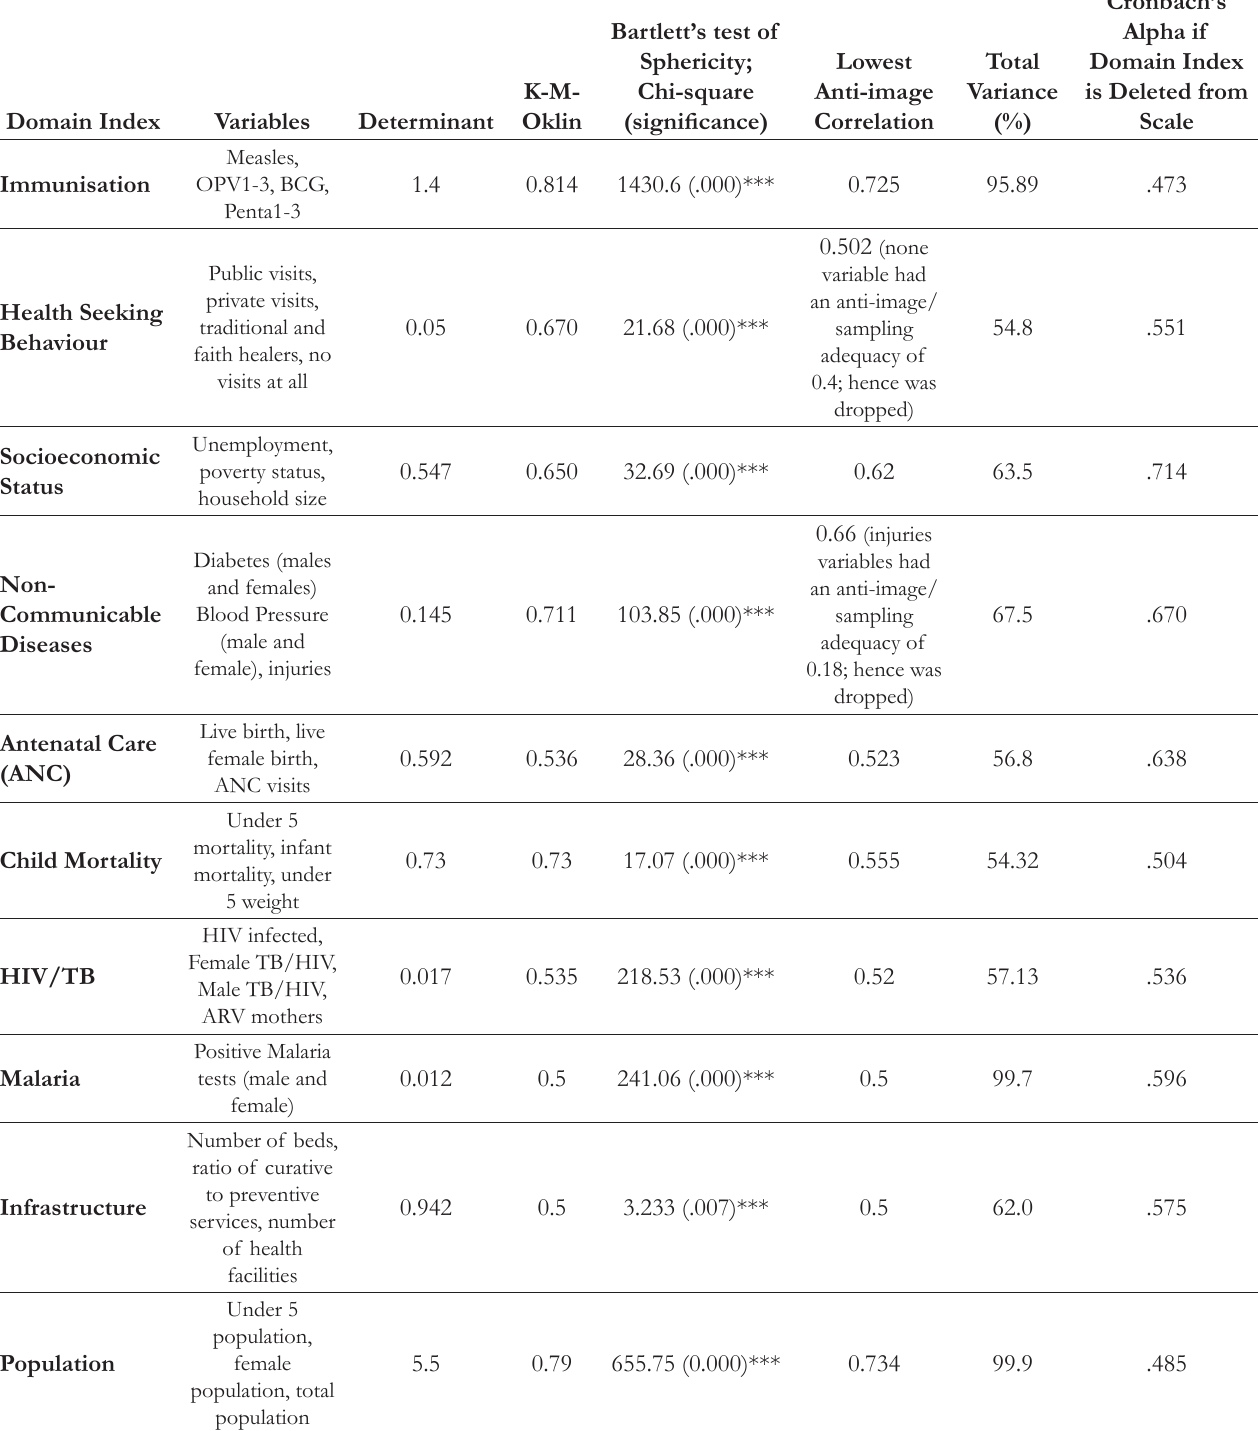
Table 2. Results of the Principal Component